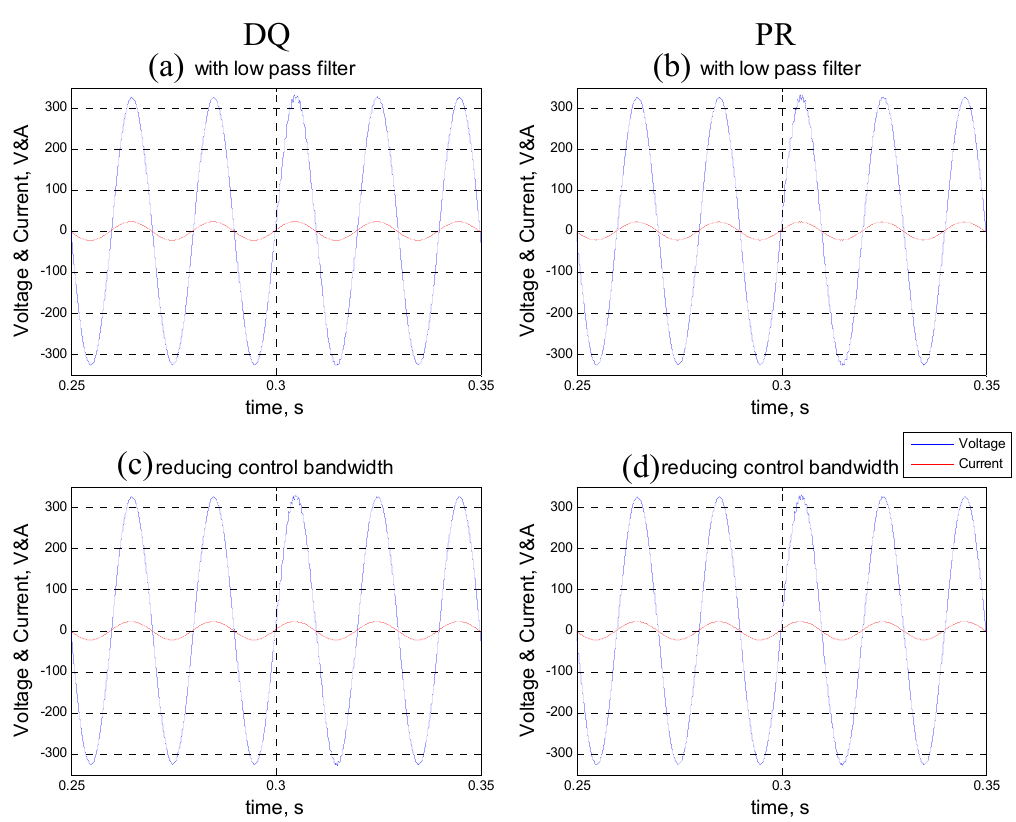
Figure 15. The simulation waveform result of ( a ) the dq-based control method with a low pass filter; ( b ) the PR-based control method with a low pass filter; ( c ) the dq-based control method with a reduced control bandwidth; ( d ) the PR-based control method with a reduced control bandwidth.